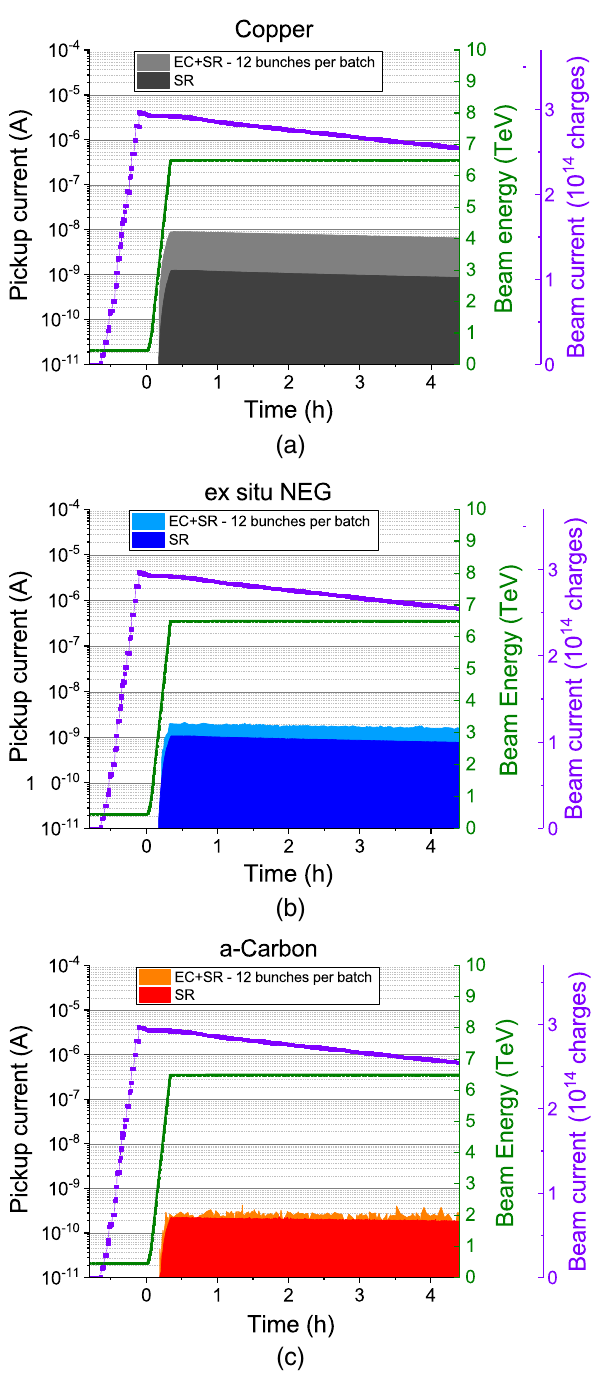
FIG. 14. EC dynamics along a 12 bunches per batch fill, comparing the total EC buildup with the effect of photoelectrons for Cu (a), ex situ NEG (b) and a-C coating